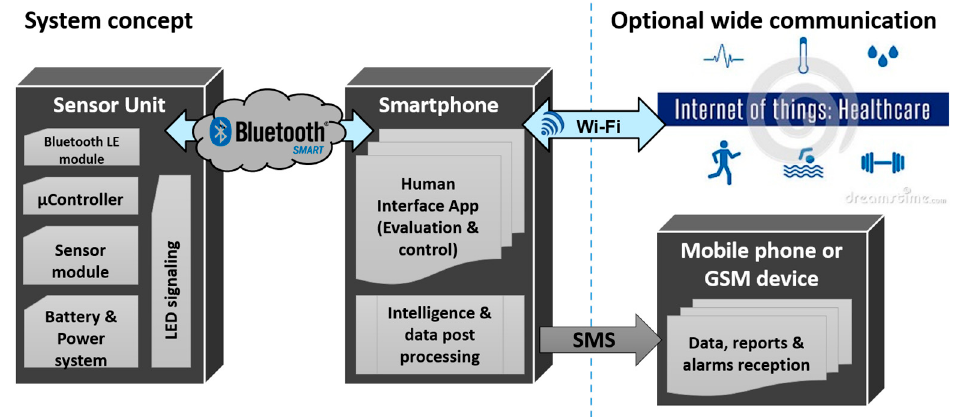
Figure 2. The concept for the technical solution is based on an add-on device to already available infrastructure, in this case a smartphone. Using Bluetooth LE protocol the raw data from the sensing components are transferred to the smart device, where the powerful CPU is used to perform data analysis tasks. All user-notification channels are controlled by the smart device.